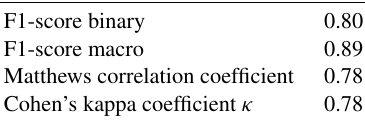
Table 4. Metrics for the comparison between binary classifications of Sentinel-1 EW and Sentinel-1 IW acquisitions on consecutive days. A total of 10 pairs of EW and IW acquisitions were